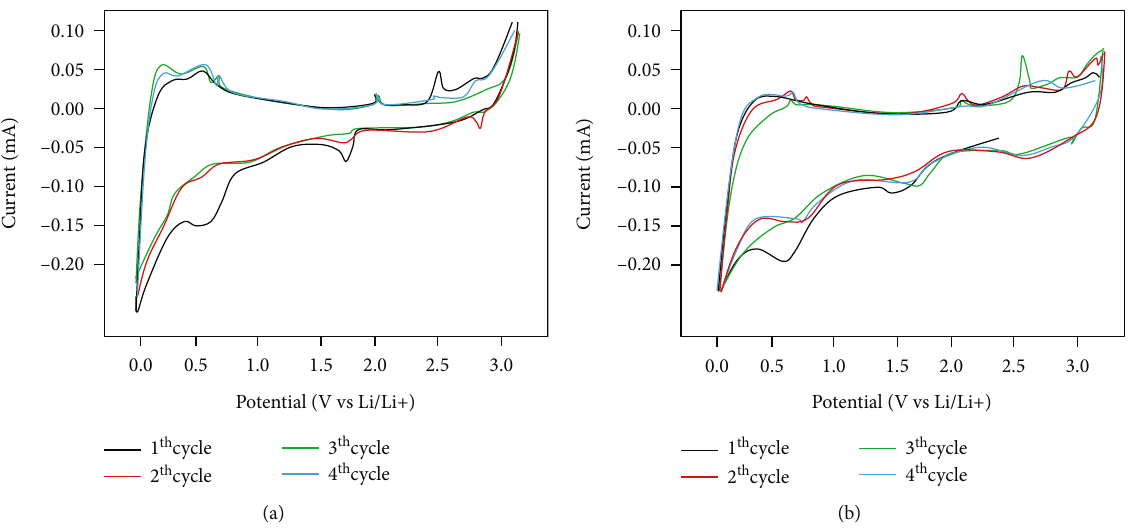
Figure 5: Cyclic voltammetry curves: (a) monomer Cs PbBr3; (b) complex Cs PbBr3@CNT.